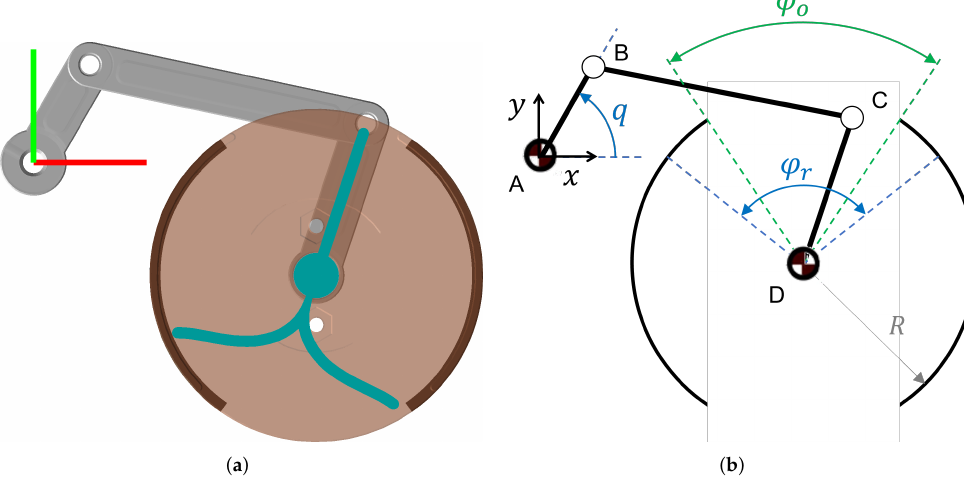
Figure 1. Design of the proposed mechanism. CAD model ( a ) with the four-bar linkage system (light grey) and the rotary distributor with the blades (teal green); mathematical model ( b